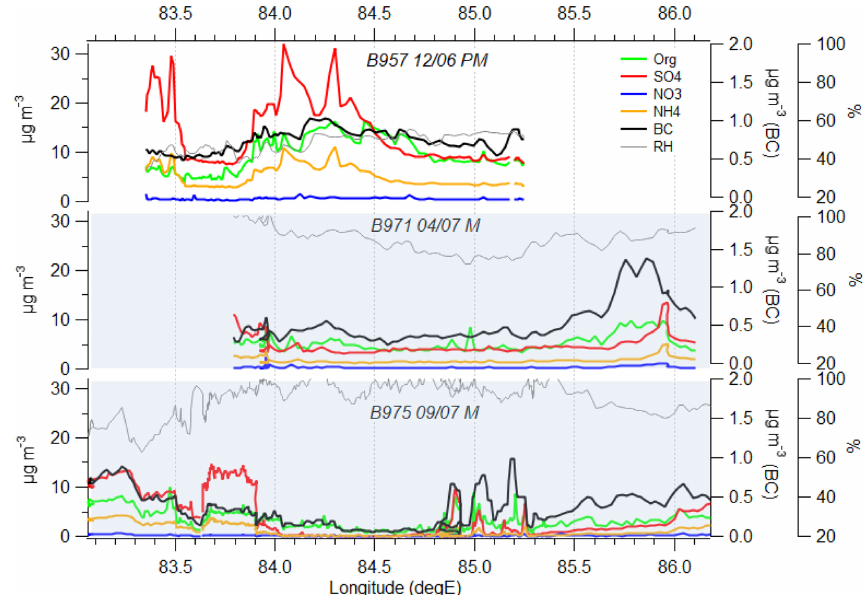
Figure 7. Horizontal spatial aerosol chemical composition (below 1000m) plots for pre-monsoon (PM) and monsoon (M) seasons in northern India, from Lucknow to Bhubaneswar. The monsoon progression is indicated by the blue shaded region.